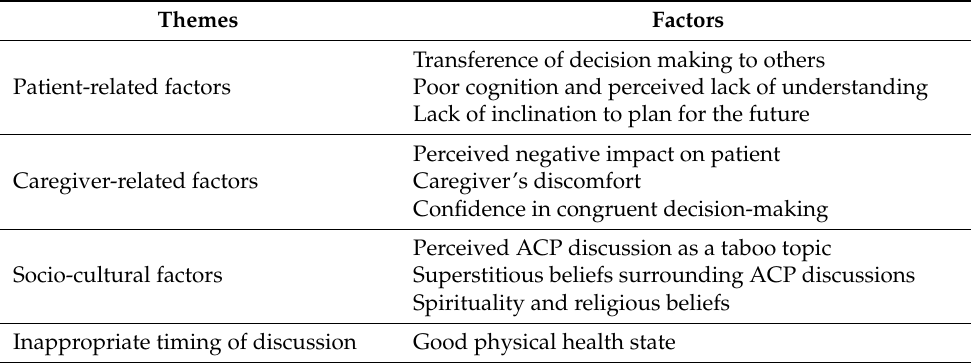
Table 3. Barriers to advance care planning